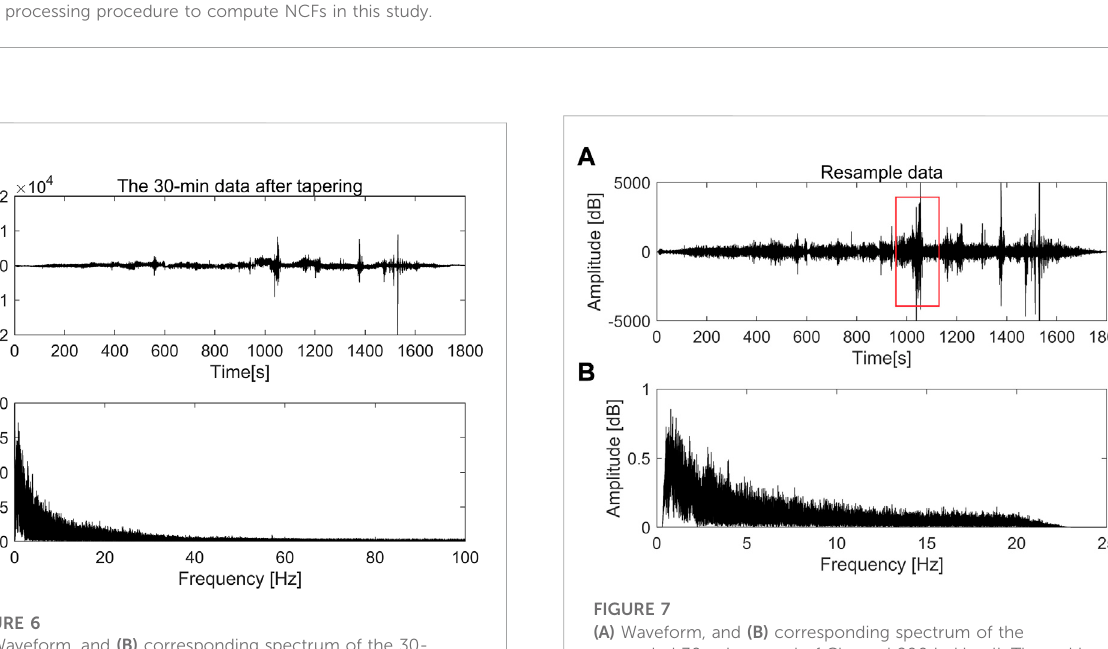
FIGURE 5 Data processing procedure to compute NCFs in this study.